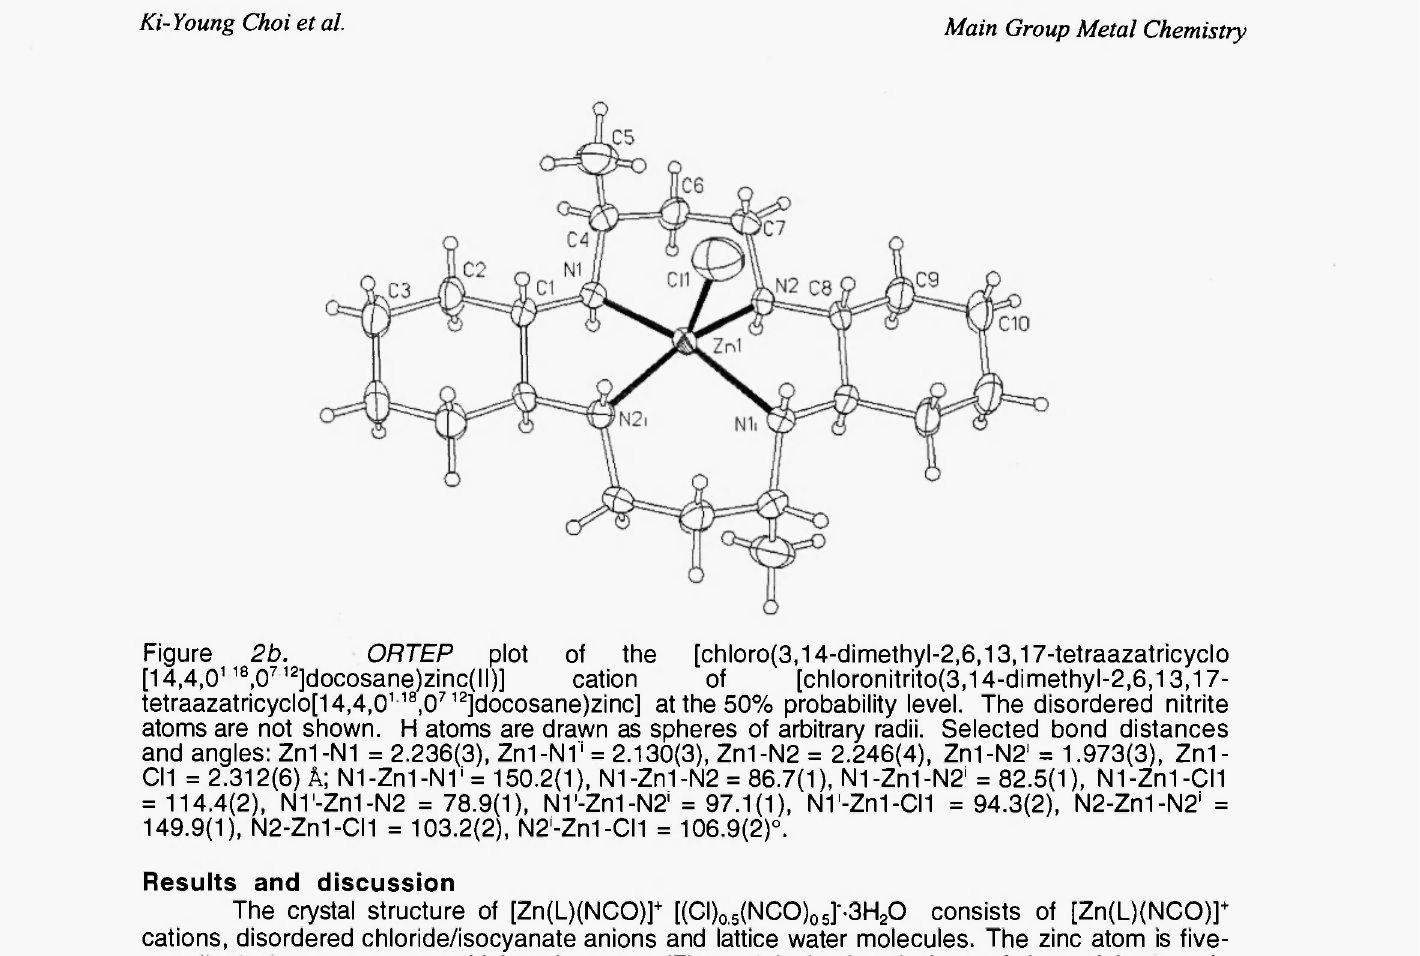
Figure 2 b. ORTEP plot of the [chloro(3,14-dimethyl-2,6,13,17-tetraazatricyclo [14,4,0 118 ,0 712 ]docosane)zinc(ll)] cation of [chloronitrito(3,14-dimethyl-2,6,13,17- tetraazatricyclo[14,4,0' 18 ,0 712 ]docosane)zinc] at the 50% probability level. The disordered nitrite atoms are not shown. Η atoms are drawn as spheres of arbitrary radii. Selected bond distances and angles: Zn1-N1 = 2.236(3), Zn1-Nf = 2.130(3), Zn1-N2 = 2.246(4), Zn1-N2 = 1.973(3), Zn1- CI1 = 2.312(6) A; N1-Zn1-Nf = 150.2(1), N1-Zn1-N2 = 86.7(1), N1-Zn1-N2 j = 82.5(1), N1-Zn1-CI1 = 114.4(2), N1'-Zn1-N2 = 78.9(1), N1'-Zn1-N2 i = 97.1(1), Nr-Zn1-CI1 = 94.3(2), Ν2-Ζη1-Ν2' = 149.9(1), N2-Zn1-CI1 = 103.2(2), N2 i -Zn1-CI1 = 106.9(2)°. Results